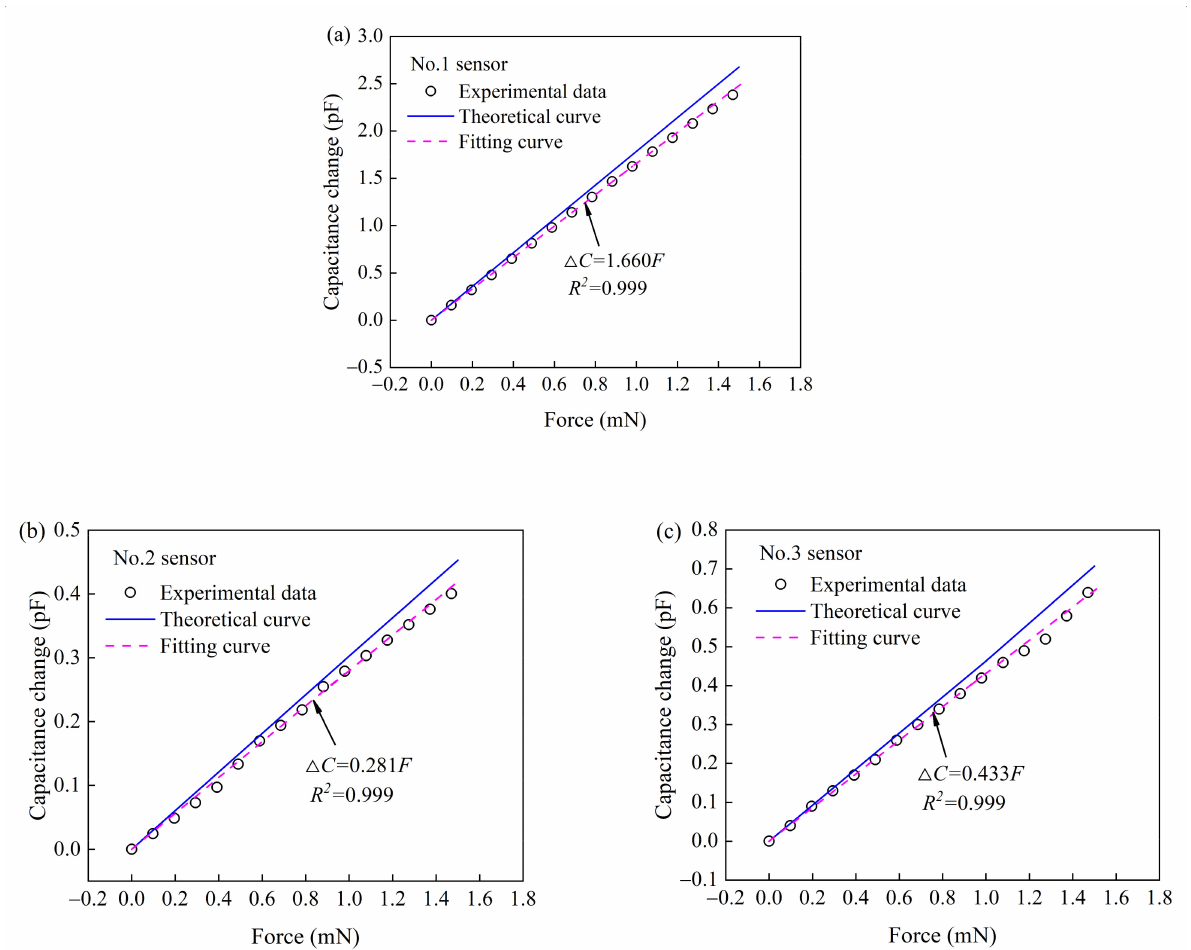
Figure 9. Capacitance change with the force applied to ( a ) No.1, ( b ) No.2, and ( c ) No.3 sensor.